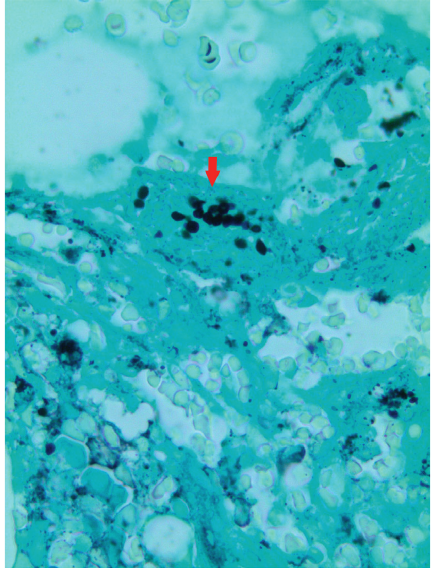
Figure 4: Grocott-Gomori methenamine silver stain: histoplasma organisms noted in bone marrow core biopsy showing yeast forms consistent with histoplasma